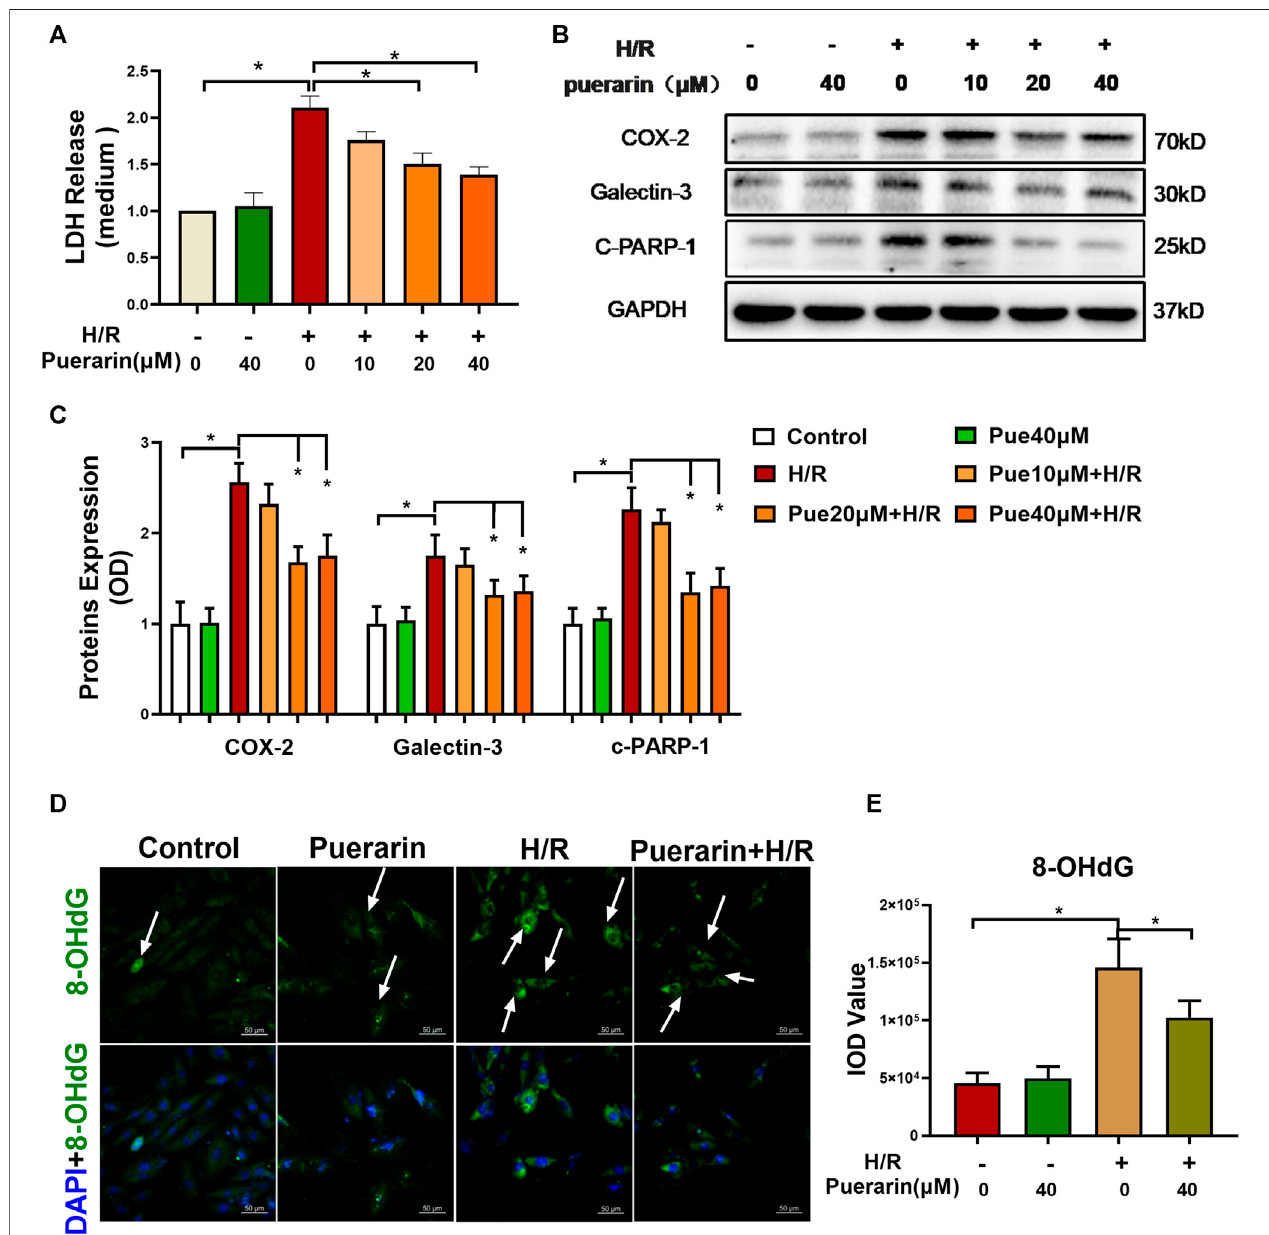
FIGURE 2 | In vitro cardioprotective activity of puerarin against hypoxia/reoxygenation injury. (A) Determination of LDH release from H9c2 cells. After exposure to 3 h hypoxia (0.1% O 2 ) and 24 h reoxygenation, H9c2 cells were treated with/without puerarin (10, 20, and 40 μ M) for 1 h. LDH release was measured by a commercial LDH cytotoxicityassaykit. (B) WesternblotanalysisofCOX2,galectin-3andcleaved-PARP-1expression.H9c2cellswerecollectedandtheproteinswereanalyzedbyWesternblot withantibodiesagainstCOX2,galectin-3,cleaved-PARP-1. (C) Quanti fi cationofCOX2,galectin-3andcleaved-PARP-1expression.TheblotsfromPanelBwerequanti fi ed by a densitometric method. (D) Immunostaining of 8-OHdG. H9c2 cells were probed with anti-8-OHdG antibody and visualized with Alexa Fluor 488-conjugated secondary antibody,whereasthecellnucleiwerestainedwithDAPI.Scalebar,50 μ m. (E) Quanti fi cationof8-OHdGgeneration.Theresultswerepresentedasmean ± SD( n (cid:2) 3).* p < 0.05.